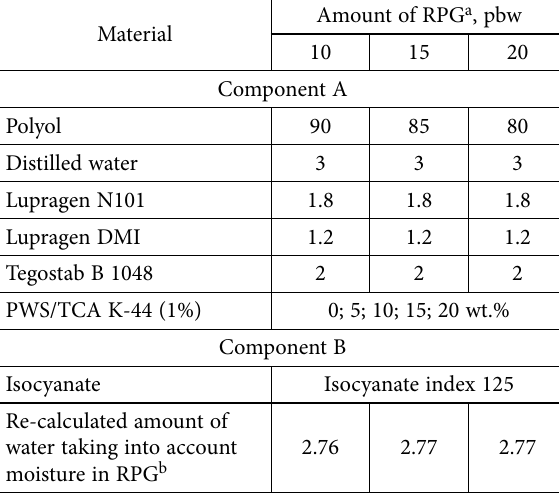
Table 2. Composition of polyurethane foam composites extended with RPG and modified with